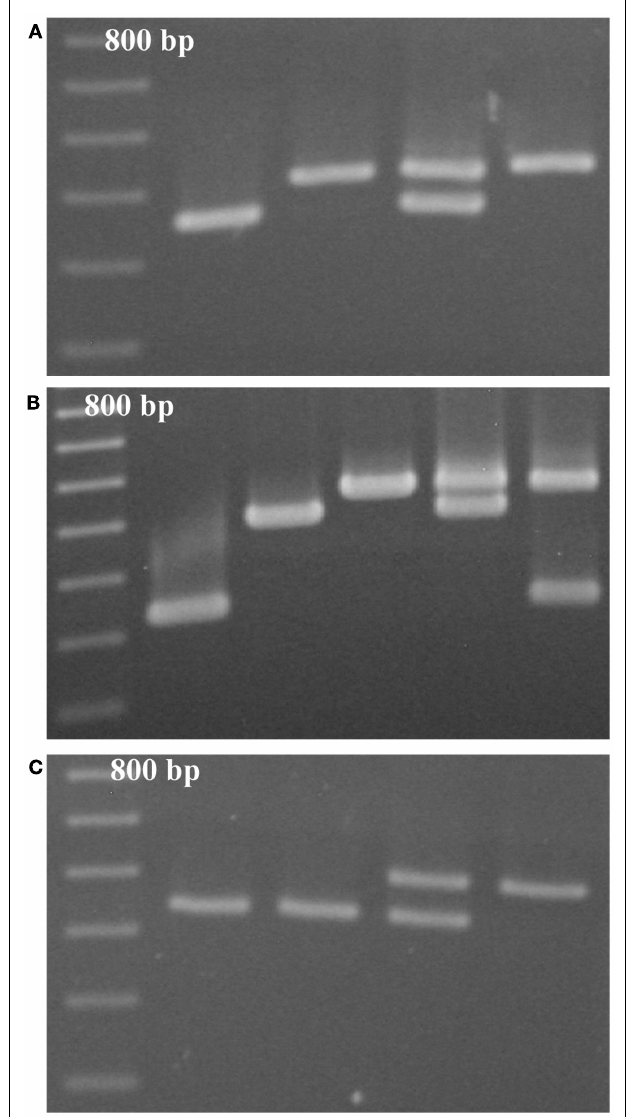
FIGURE 1 | Resolution of alleles ofVNTR-type markers (A) D9BrapaS1 , (B) D9BrapaS4 , and (C) D1BrapaS1 on 1.2% agarose gels. The first lane in each gel is a 100-bp DNA ladder.